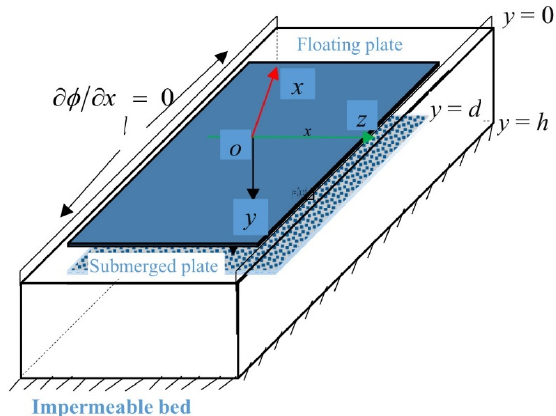
Figure 12. Graphical definition of the wave basin.